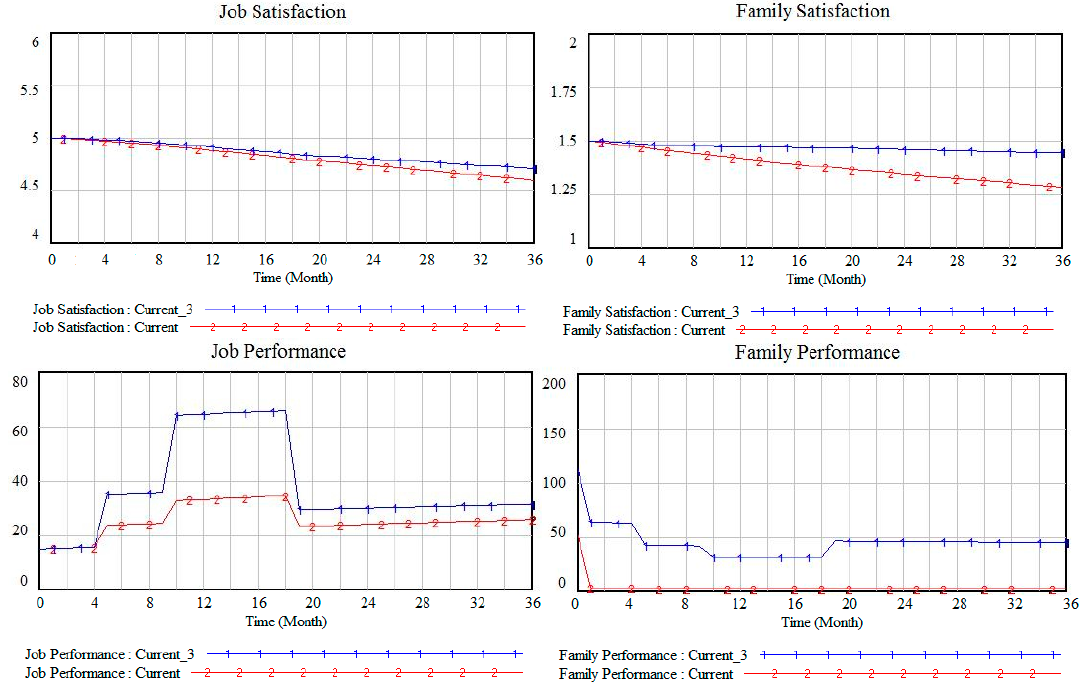
Figure 8. Satisfaction and performance under different organizational support.